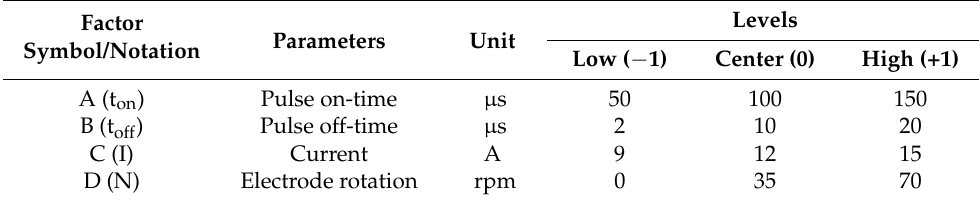
Table 2. Design scheme of machining parameters and their levels. Factor Symbol/Nota-